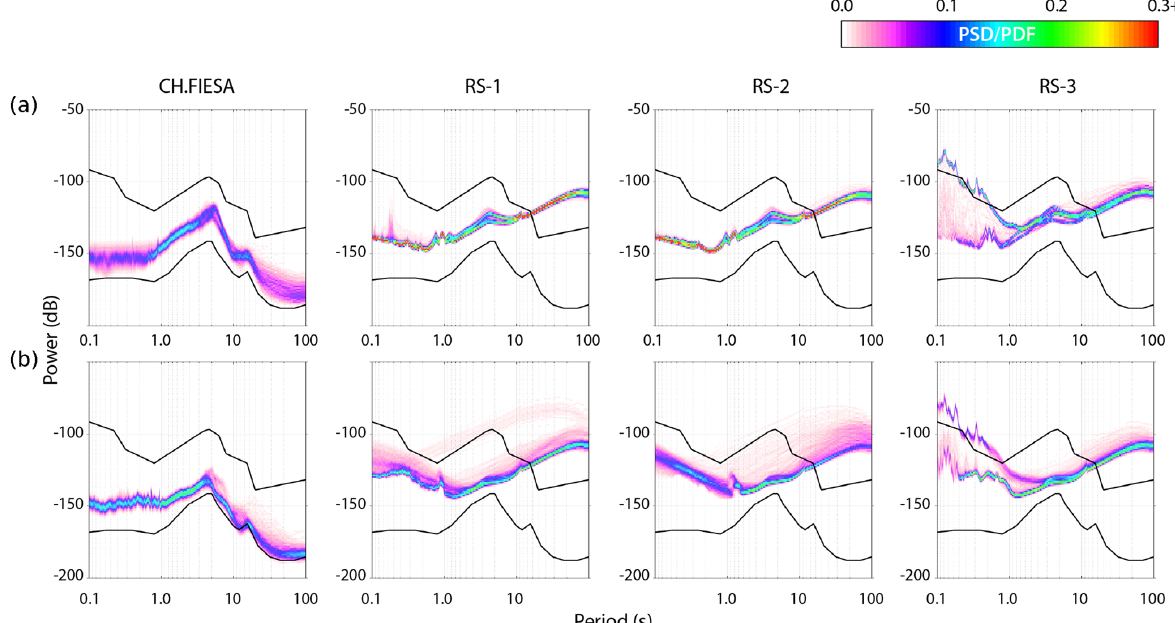
Figure 2. Comparison of background-noise levels between a broadband station (CH.FIESA) and the Raspberry Shake stations (RS-1, RS-2, and RS-3) installed in the Aletsch region for 1 year. Probability density functions (PDFs) of the power spectral densities (PSDs) were com- puted by stacking windows of 10min in two reference weeks, one in winter ( a , 1–8 March 2017) and one in summer ( b , 1–8 August 2017). The black lines represent high and low reference noise models. The broadband station CH.FIESA managed by the Swiss Seismological Ser- vice is installed in the Aletsch region about 5km away from the RS network. Branching of PSD/PDF at RS-3 is caused by diurnal operations of the cable